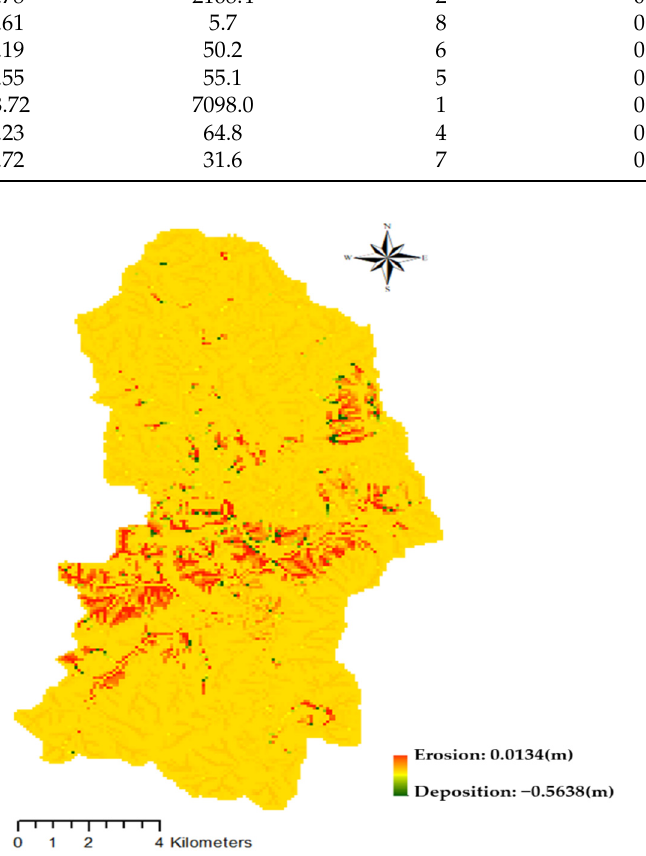
Figure 13. Spatial distribution of net erosion by the calibrated MR-SSEM (Typhoon Rusa). Table 10. Results of erosion for land use (the calibrated model, Typhoon Rusa).